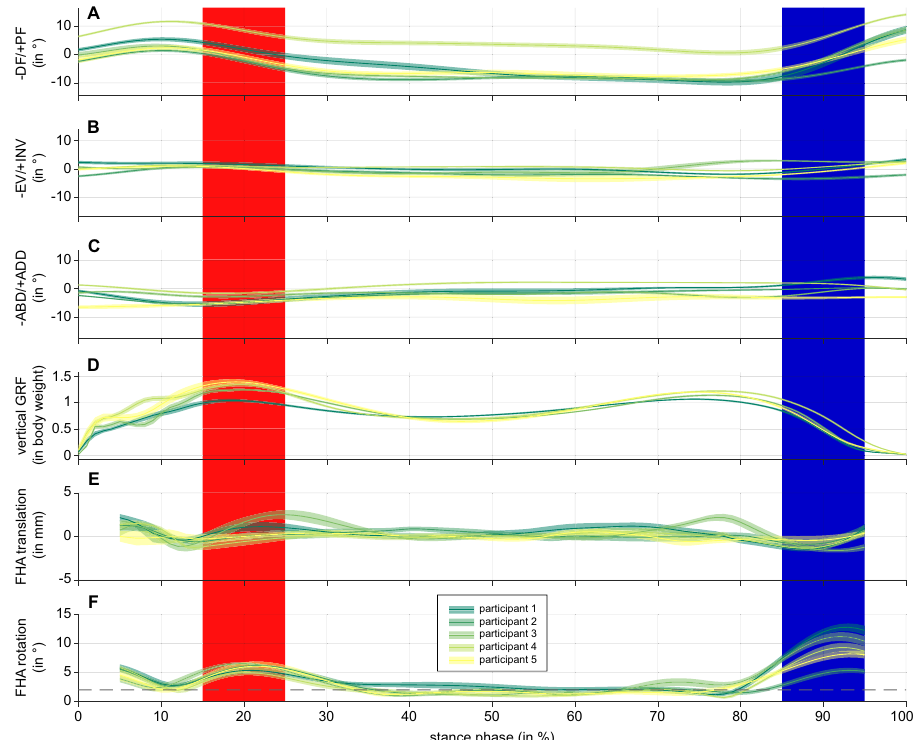
Figure 1. ( A ) Talar position relative to tibia during stance phase of walking in the sagittal plane. Zero degree corresponds to position in relaxed standing. Negative values represent a dorsiflexed (DF) position of the talus relative to tibia, positive values a plantarflexed (PF) position. Mean values (straight line) and corresponding 95% confidence interval (shaded area) are presented for the five participants. Red area indicates the period of the stance phase considered as dorsiflexion movement, blue area as plantarflexion movement. ( B ) Talar position relative to tibia during the stance phase in the frontal plane. Negative values represent an everted (EV), positive an inverted (INV) position. ( C ) Talar position relative to tibia during the stance phase in the transverse plane. Negative values represent an abducted (ABD), positive an adducted (ADD) position. ( D ) Vertical ground reaction Force (GRF) during the stance phase of walking, scaled to body weight. Participant 2 not shown as data acquisition failed. ( E ) Translation along the finite helical axis. As for the calculation of the finite helical axis two time points were chosen being 10% of stance phase apart, values are presented from 5 to 95% stance phase. ( F ) Rotation about the finite helical axis. The orientation of a determined finite helical axis was subsequently only considered when a minimum of 2 degrees (dashed line) was